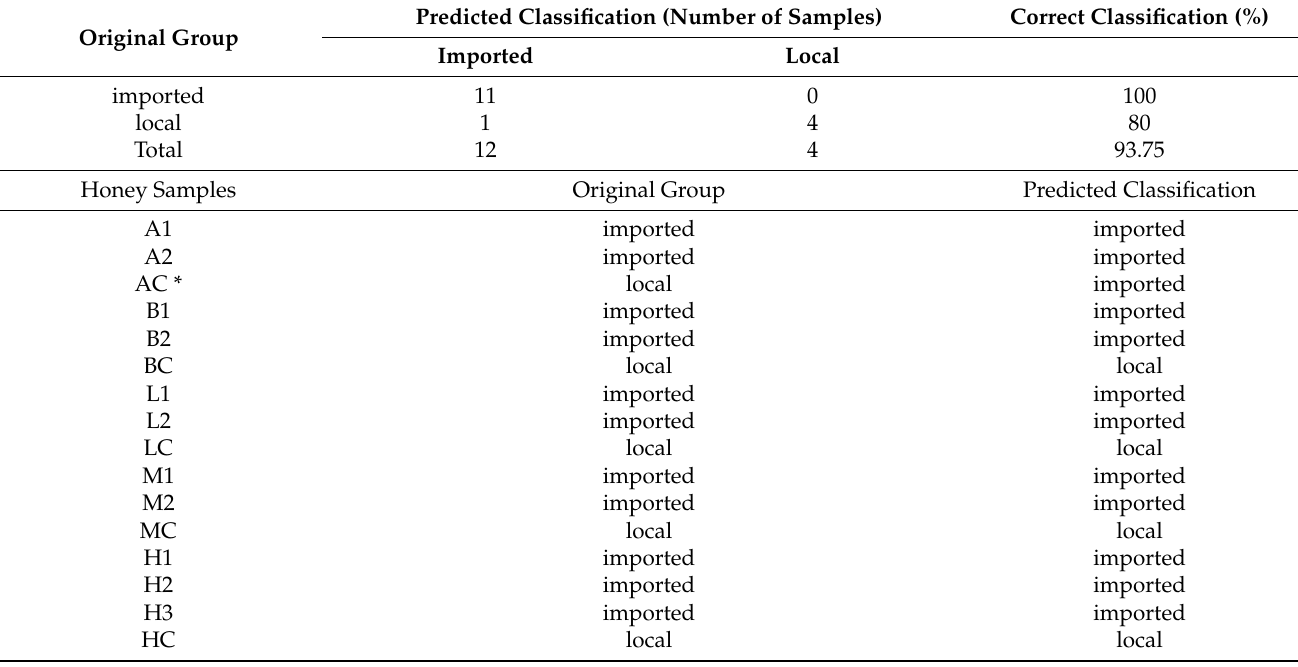
Table 3. Results of stepwise discriminant analysis (LDA) for all the samples considered of different origin, and classification matrix for individual honey